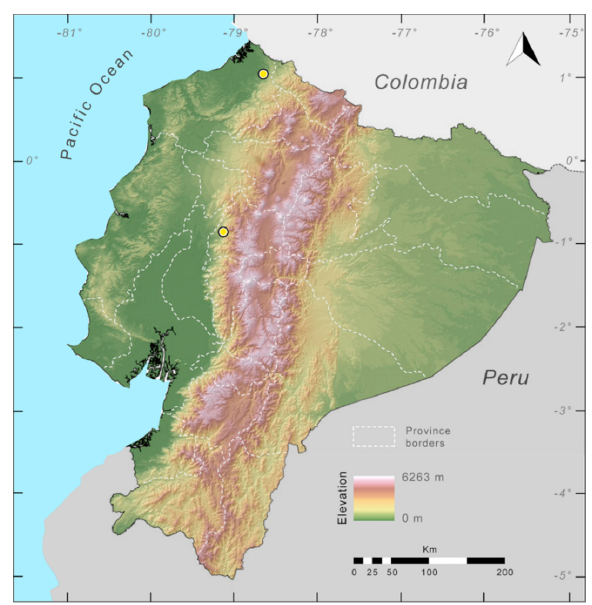
Figure 68. Distribution of Cochranella granulosa in Ecuador (yellow dot).